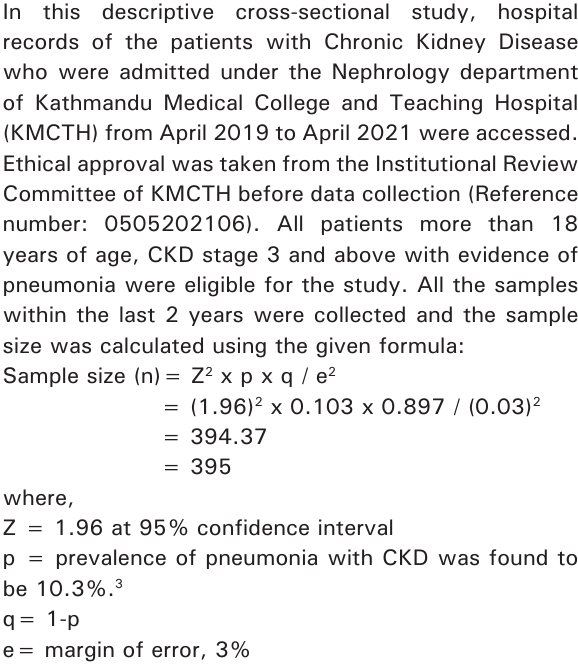
Table 1. Frequency by *CKD grades.